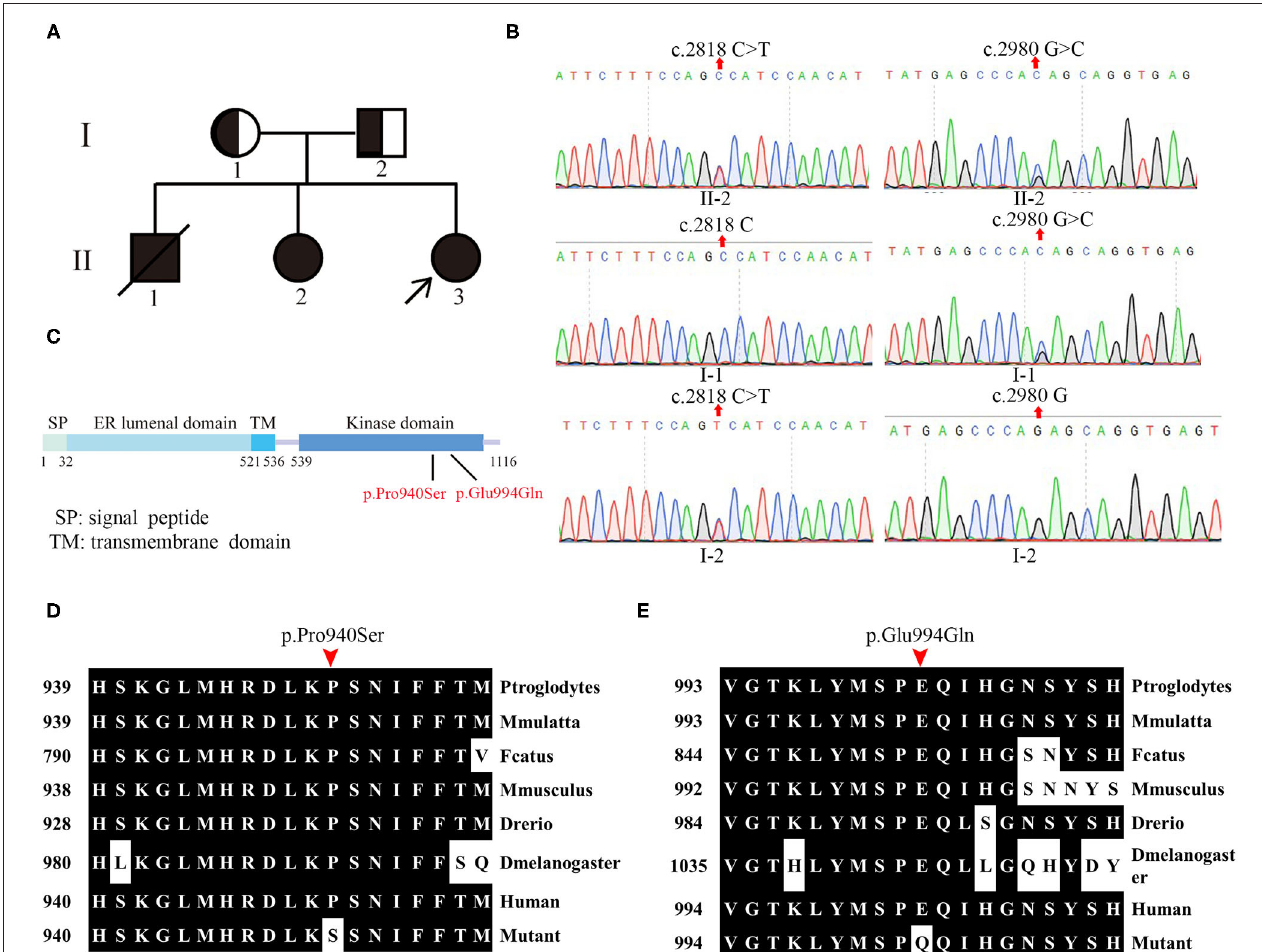
FIGURE 1 | Pedigree and genotype of patients. (A) Pedigree of patients from the Chinese Wolcott–Rallison syndrome (WRS) family. The families involved in this study. Squares indicate male, circles indicate female, blackened symbols denote affected individuals, and half-blacked symbols denote the mutation carriers. The proband is indicated by arrows ( ր ). (B) The sanger sequencing analysis of the family. (C) Linear schematic of the protein structure of wide-type PERK. (D,E) Evolutionary conservation of amino acid residues altered by the mutations across different species.